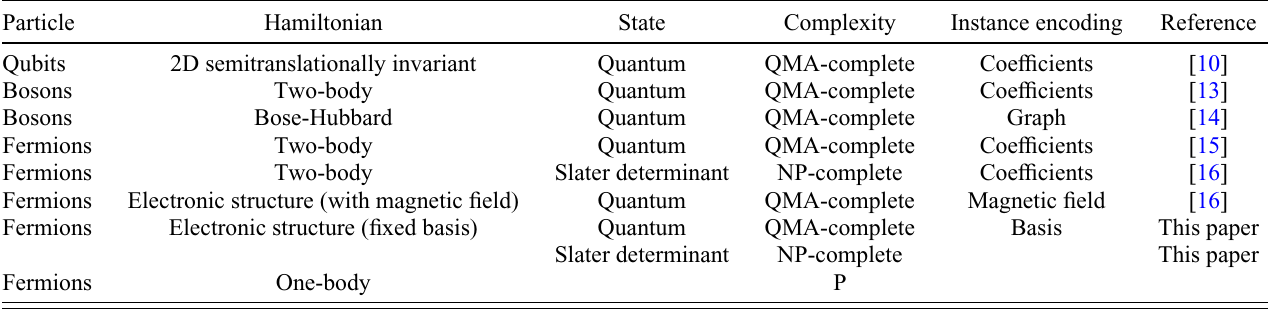
TABLE I. Known results for physically realistic Hamiltonians. The result for qubits is representative but many similar results are known (see, e.g., Refs. [11,12]). The results for bosons and fermions are exhaustive, to the knowledge of the authors. Particle